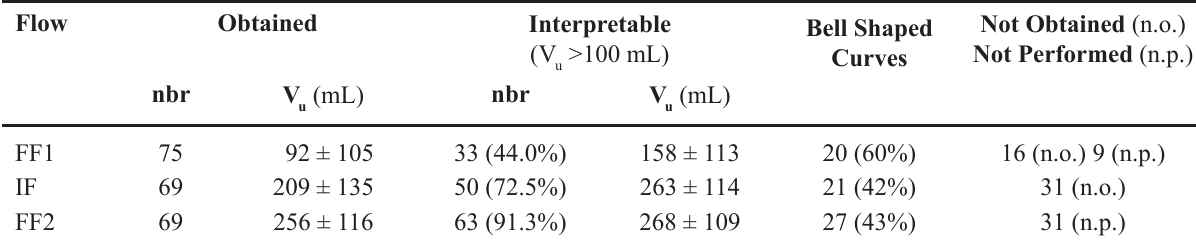
Table 3 – Feasibility of free and intubated flows during the urodynamic session. Flow Obtained Interpretable Bell Shaped